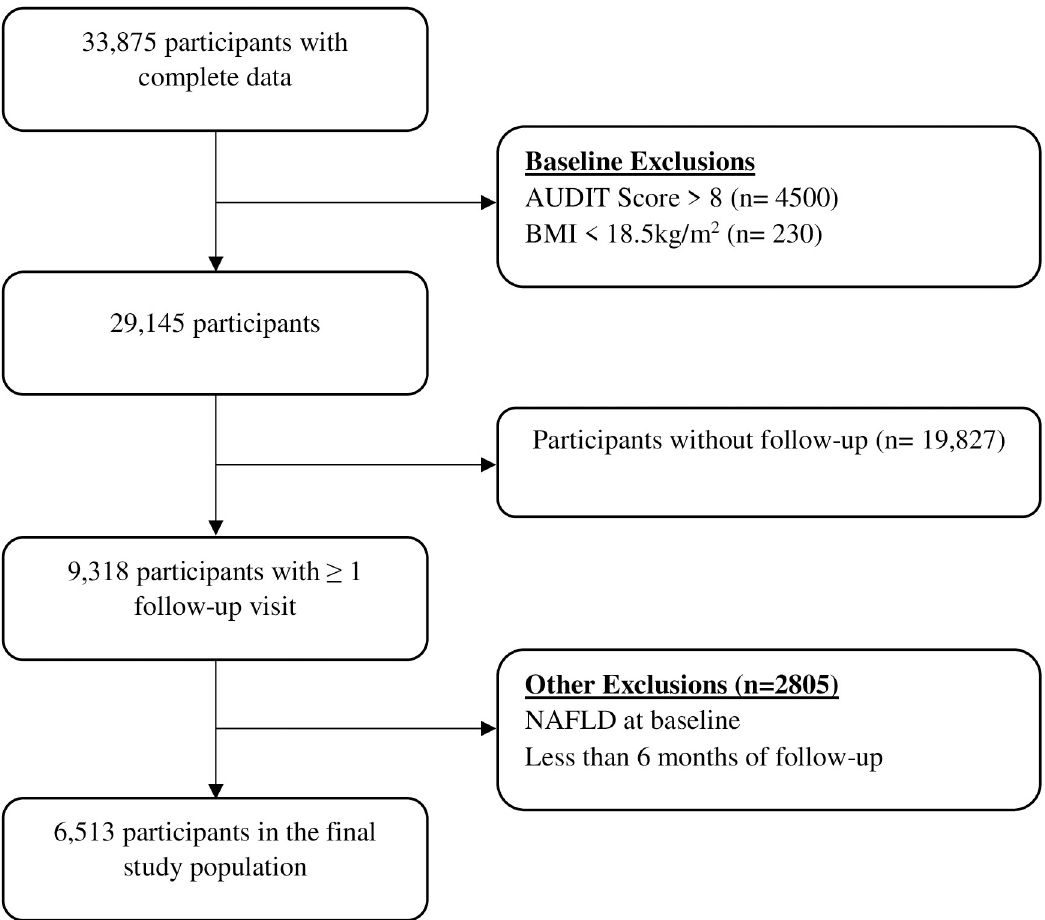
Fig 1. Study participant flow and exclusions. Participants with complete data at baseline (N = 33,875). Excluding participants with AUDIT score > 8 (n = 4500) and/or BMI < 18.5kg/m 2 (n = 230), N = 29145 were selected. Further excluding those without any follow-up visits (n = 19,827), those diagnosed with NAFLD at baseline or those with less than 6 months of follow-up data (n = 2805), the final number of study participants selected N = 6,513.